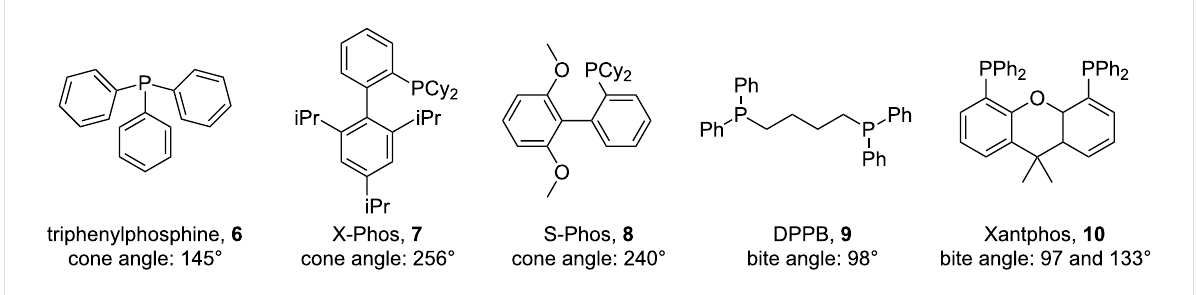
Scheme 2: Schematic diagram of the flow process.